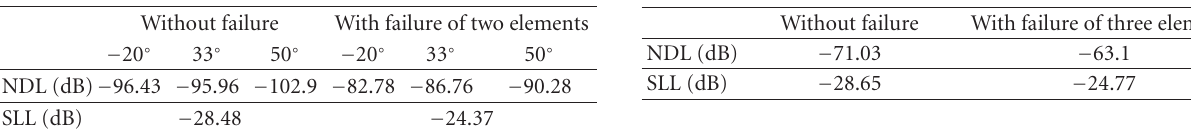
Table 8: Comparison of NDL and SLL for the configurations dis- cussed in Case 4.